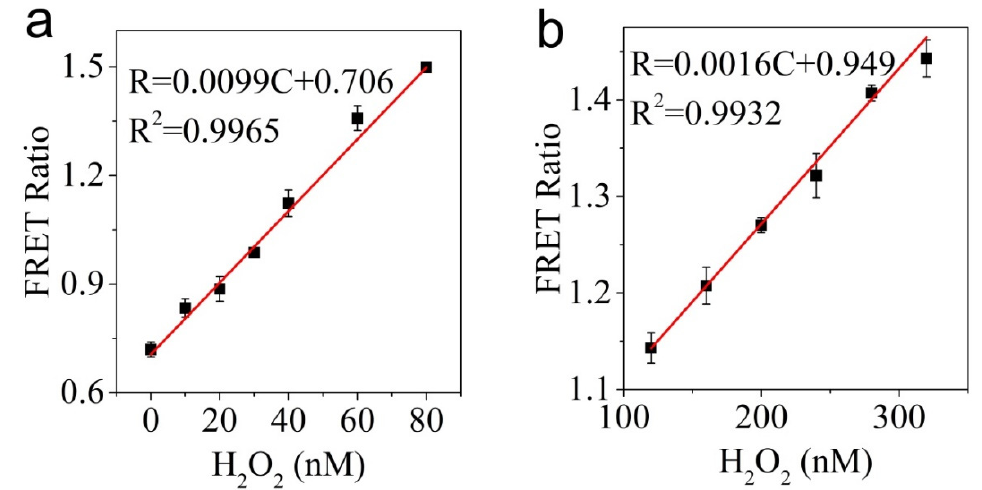
Figure 4. Titration curve of FRET in CPmTY over a serial of H 2 O 2 concentrations. ( a ) 200 nM CFP-Prx and 200 nM mTrx-YFP with 0, 10, 20, 30, 40, 60, 80 nM H 2 O 2 . ( b ) 800 nM CFP-Prx and 800 nM mTrx-YFP with 120, 160, 200, 240, 280, 320 nM H 2 O 2 .